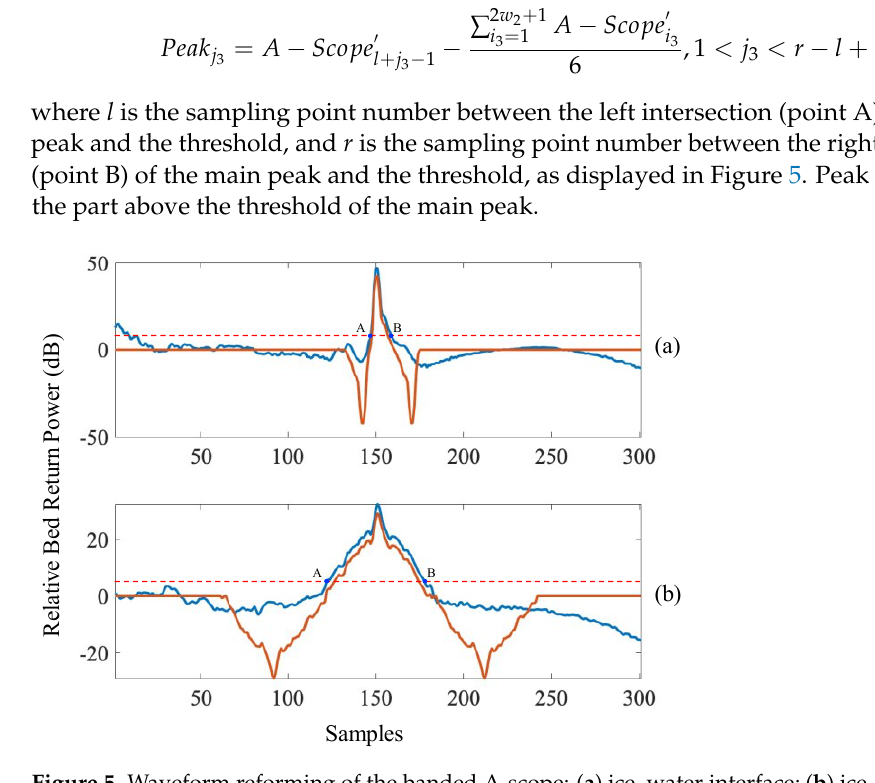
Figure 5. Waveform reforming of the banded A-scope: ( a ) ice–water interface; ( b ) ice–rock interface. The blue line is the waveform after the removal of DC drift, and the red line is the waveform after the waveform reformation.